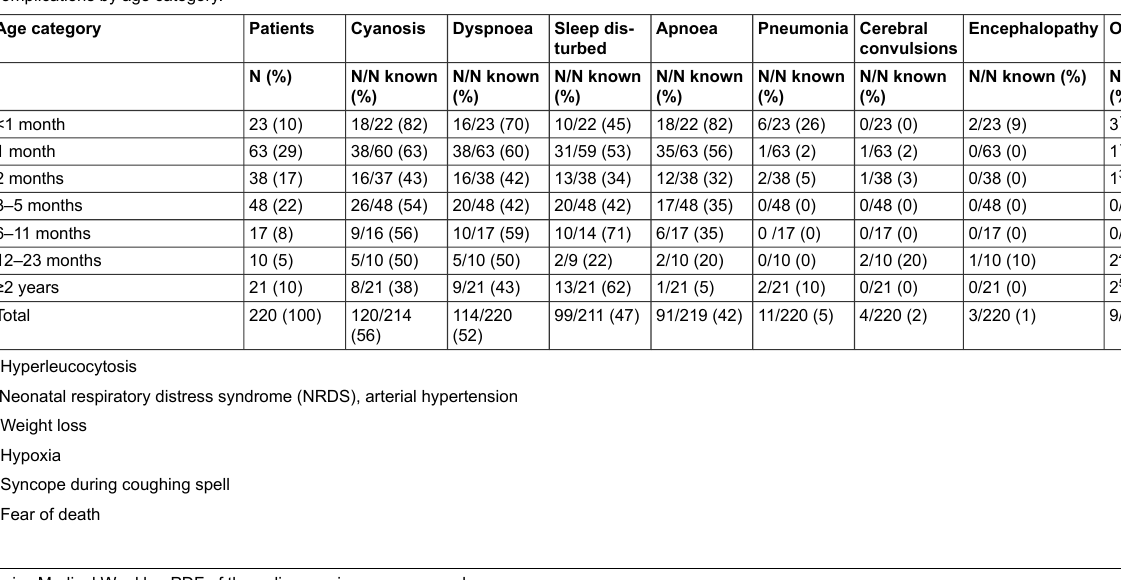
Table 3: Complications by age